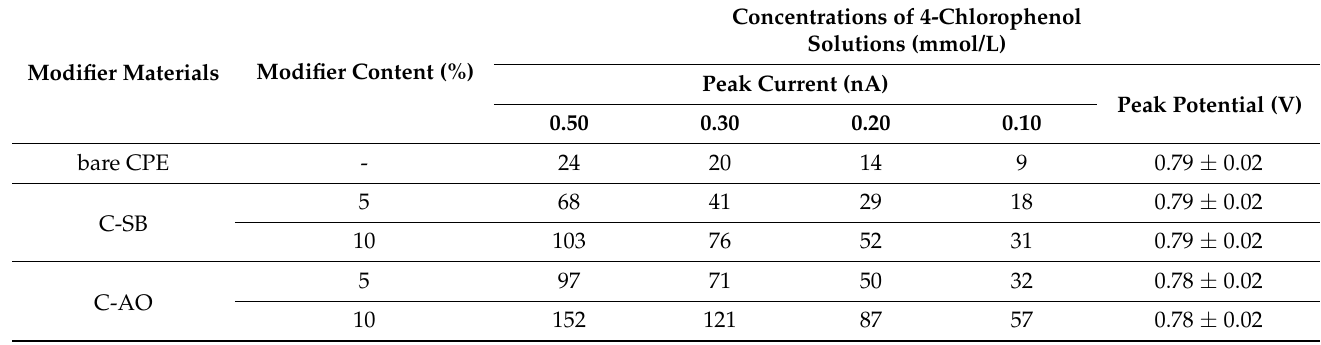
Table 2. Peak currents and potentials determined from DPV curves for carbon paste electrodes modified by adding various quantity of obtained carbon